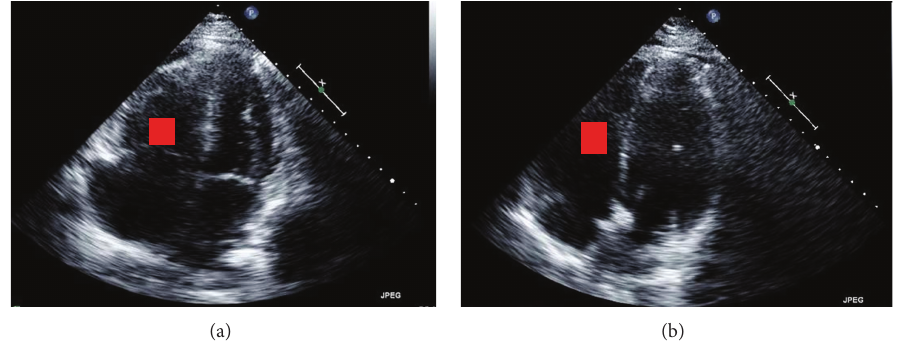
Figure 3: (a) The red square is in the right ventricle that is markedly dilated compared to left ventricle dimension. (b) The image shows the decrease in size of the right ventricle after the UAT (red